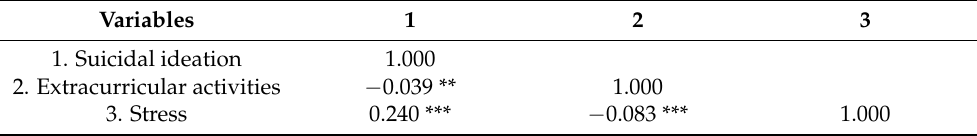
Table 2. Spearman correlation coefficients between key study variables.